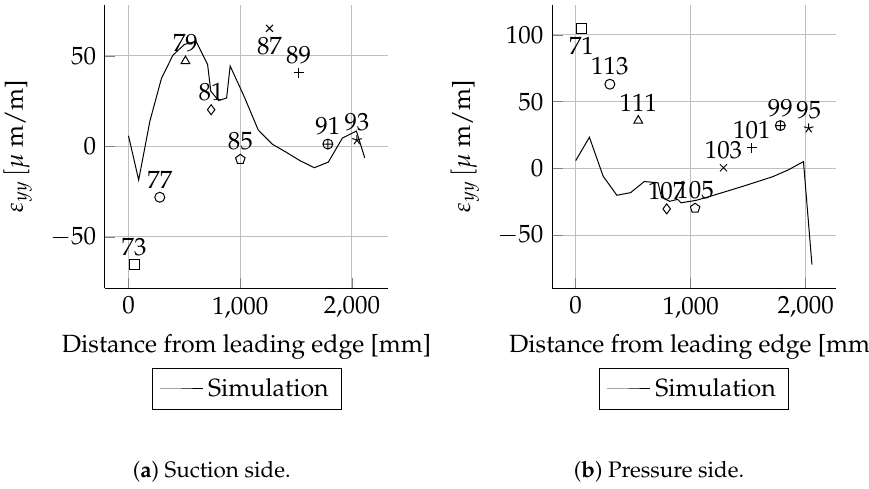
Figure A65. Strain comparison ε TT at radial position R = 8000mm for torsion load case